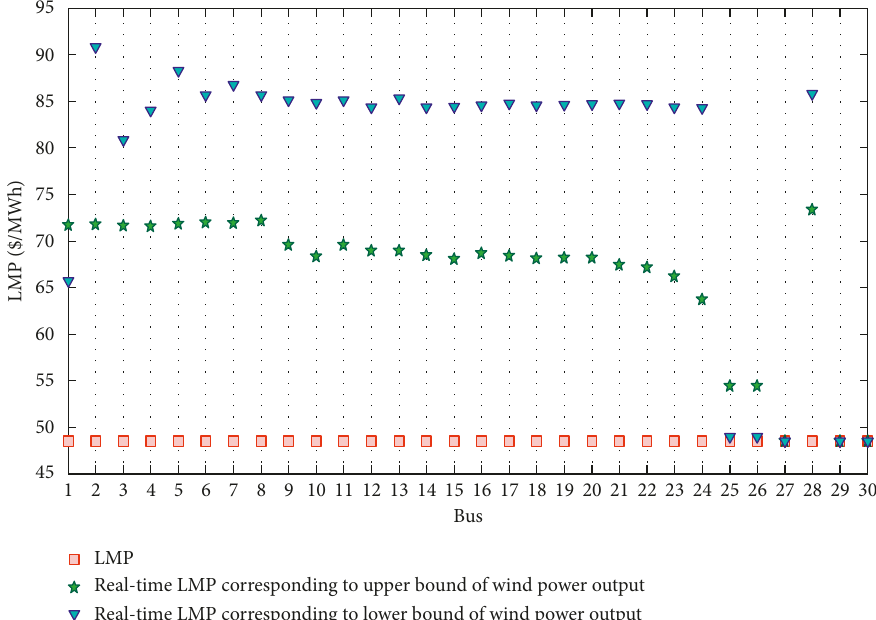
Figure 6: The obtained hour-ahead LMPs, RTLMP 1 s, and RTLMP 2 s of 30 buses after 3500 iterations in our GDCAC-based EM